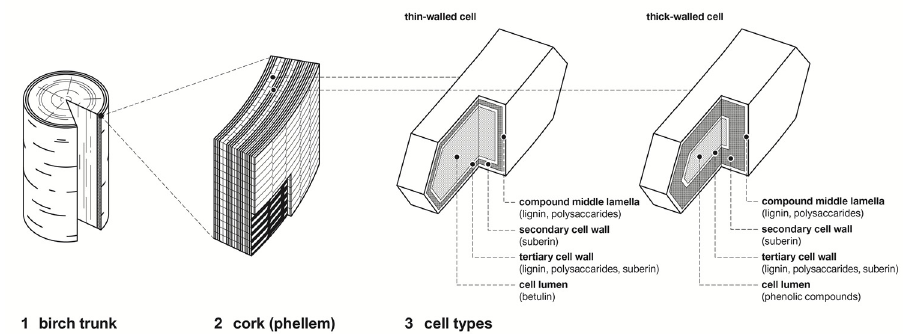
Figure 1. Schematic representation of the morphology and chemical composition of birch bark cells: 1. location of bark in trunk; 2. alternating layers of thick-walled and thin-walled phellem cells; 3. structure and chemical composition of thin- and thick-walled cells.